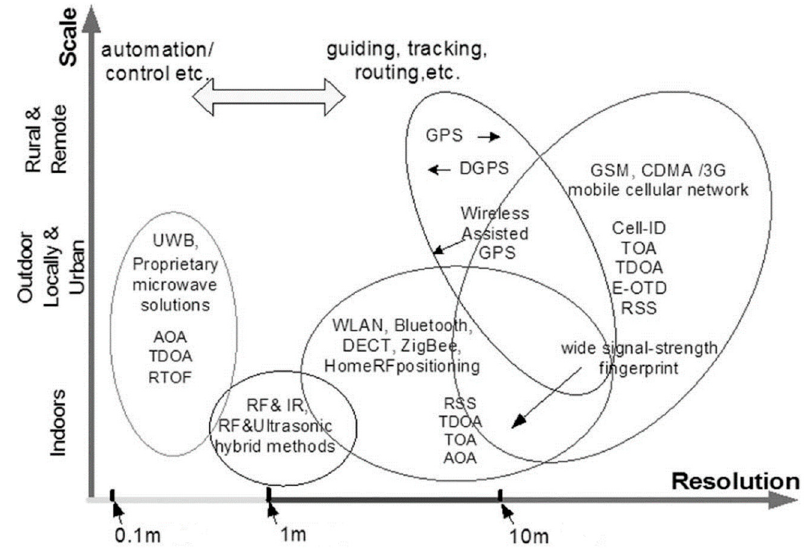
Figure 1. Currently existing wireless localization techniques.